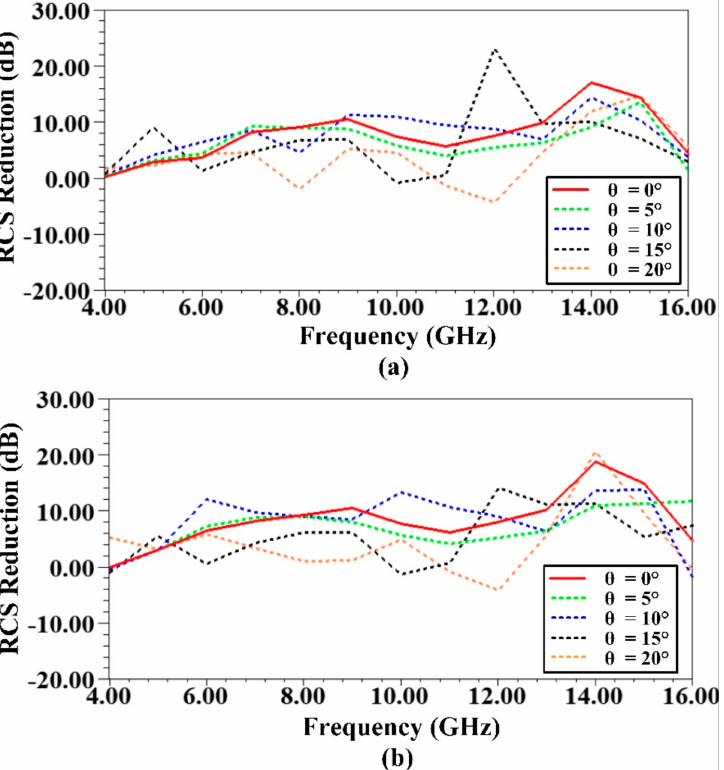
Figure 13. Simulated monostatic RCS reduction for oblique angle incidence of 5 ◦ , 10 ◦ , 15 ◦ , and 20 ◦ .